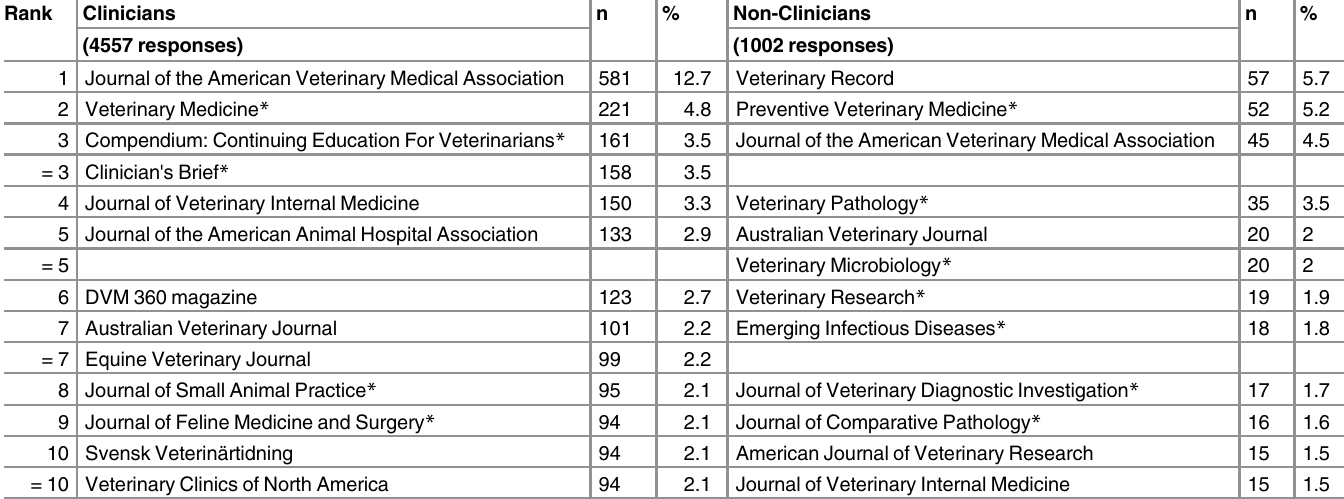
Table 5. Top ten journals most read as nominated by clinicians and non-clinicians. Respondents could nominate up to 10 different journals. Rank Clinicians n